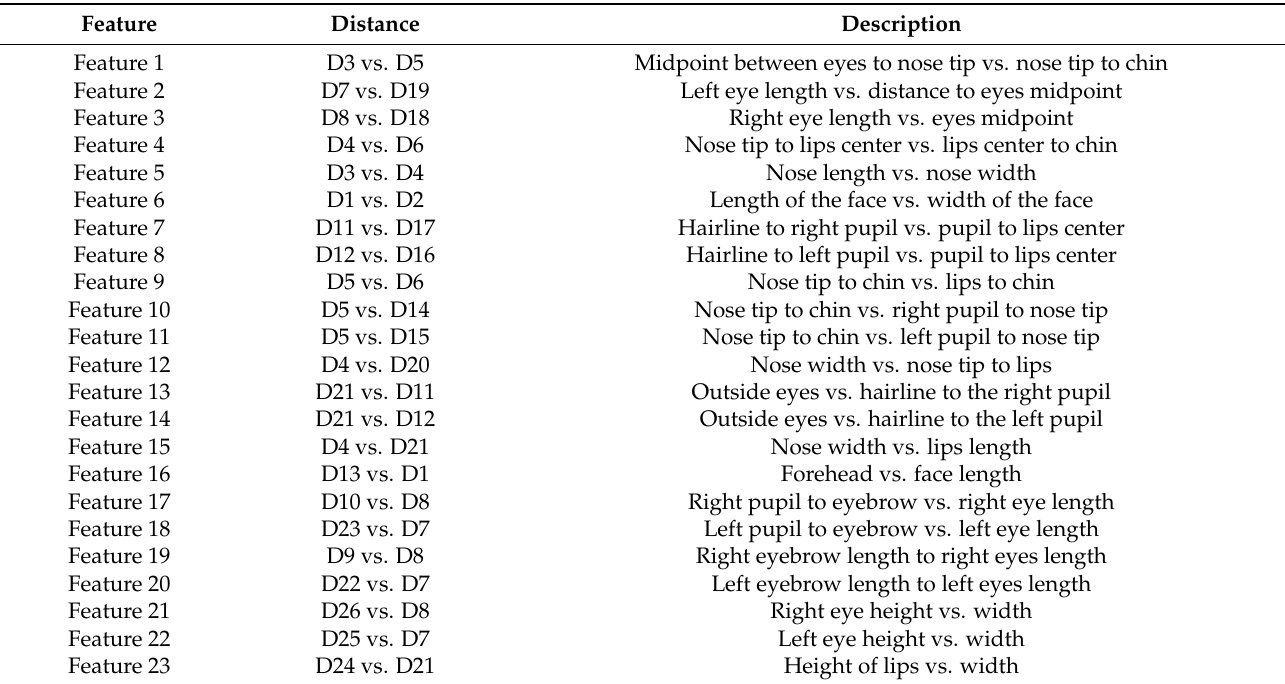
Table 3. Proposed 23 golden facial geometric